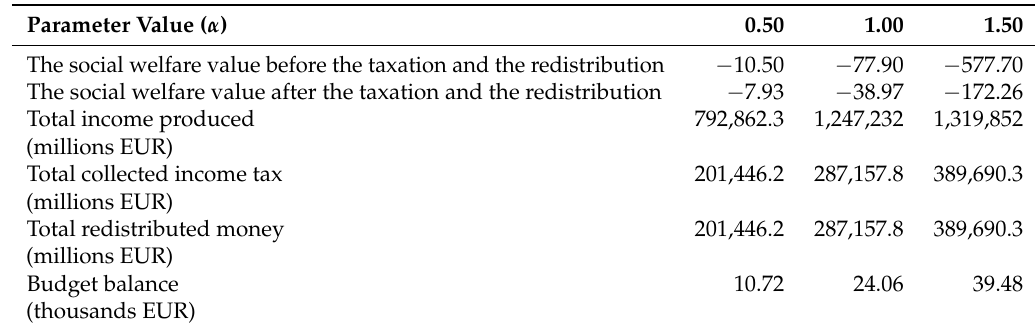
Figure 3. Average income tax rates for different α values. Table 2. Results from simulations for different α